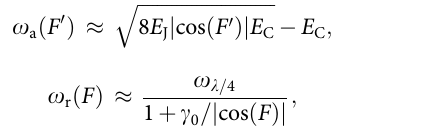
q ffiffiffiffiffiffiffiffiffiffiffiffiffiffiffiffiffiffiffiffiffiffiffiffiffiffiffiffi 8 E J cos F 0 ð Þj j E C